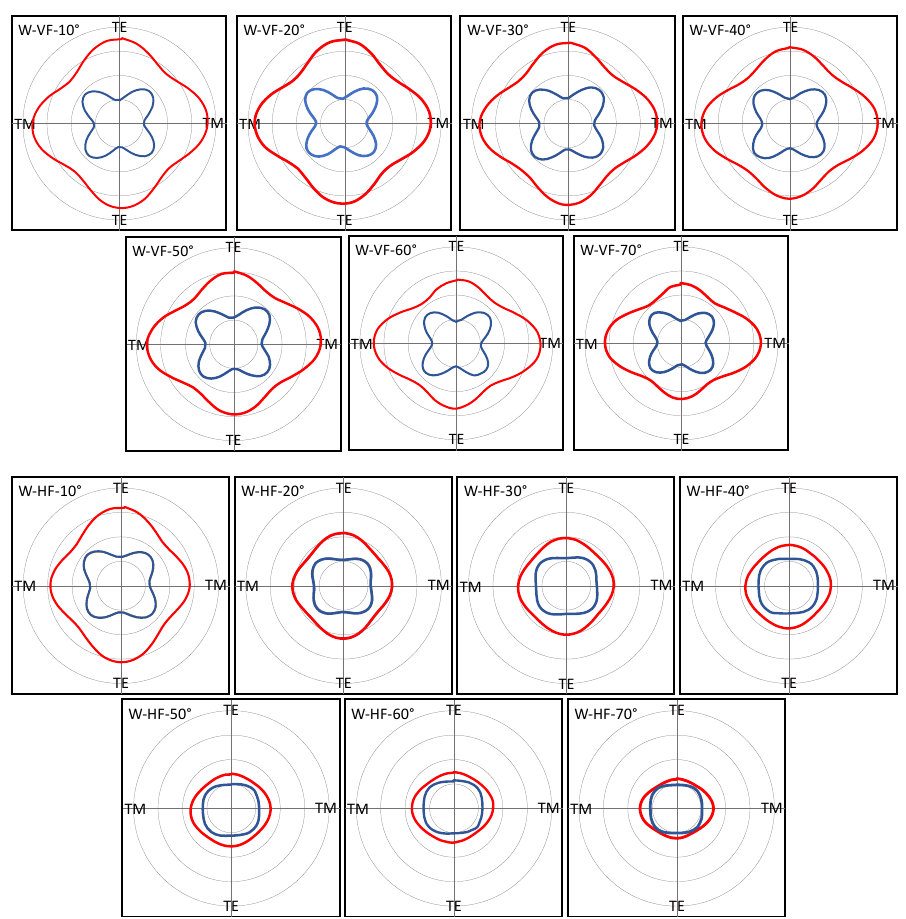
Figure 5. Polar distributions of wood radiances for polarizations parallel (red) and orthogonal (blue) to the input one. Images report the measured radiances varying the observation azimuthal angle θ view . Top images refer to wood with vertical fibres (W-VF); bottom images refer to wood with horizontal fibres (W-HF).